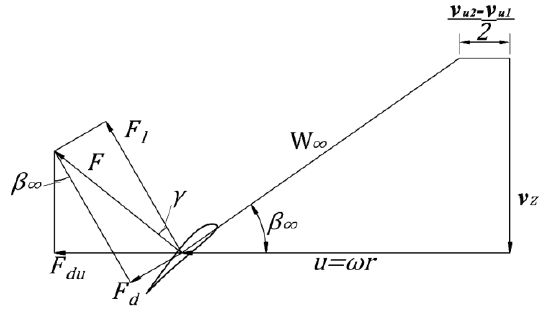
Figure 21. The velocity triangle of the rotor.